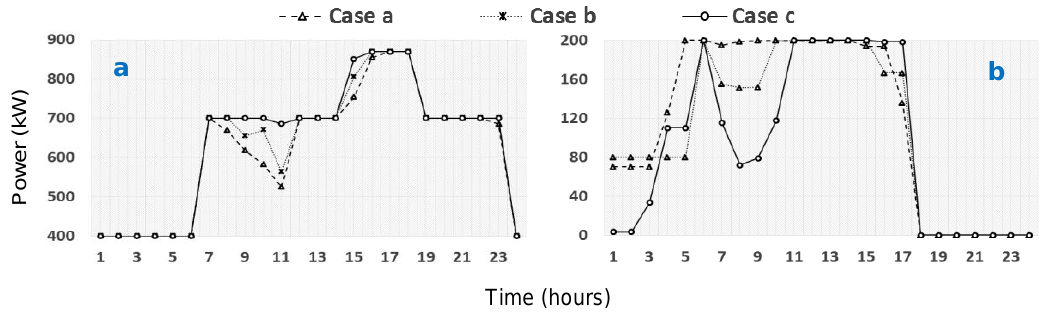
Figure 10. ( a ) Collective generation amount of CGs; and ( b ) Cumulative SOC of BESSs.